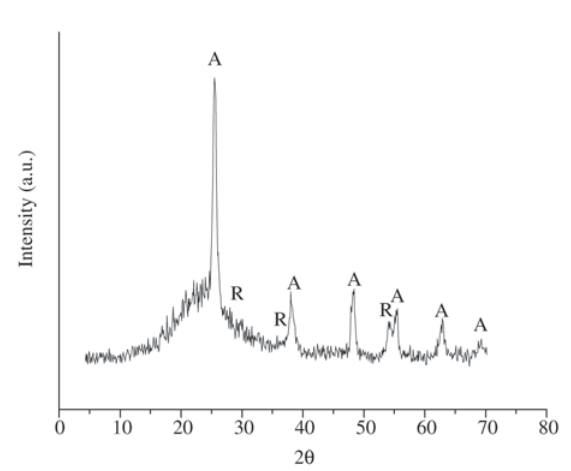
Figure 4. X ray diffraction peaks to STB